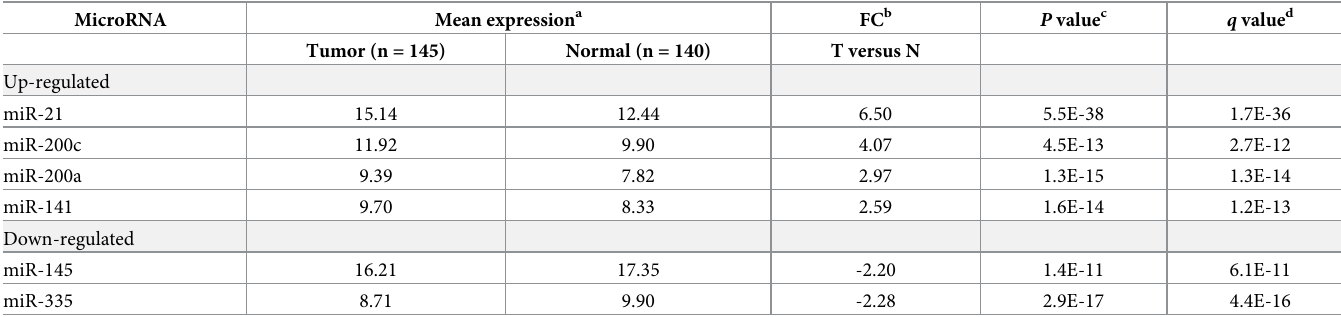
Table 5. Differential expression of miRNAs in breast